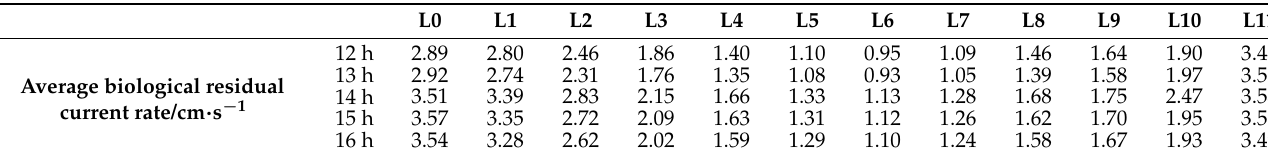
Table 3. Average biological residual current velocities at monitored points.